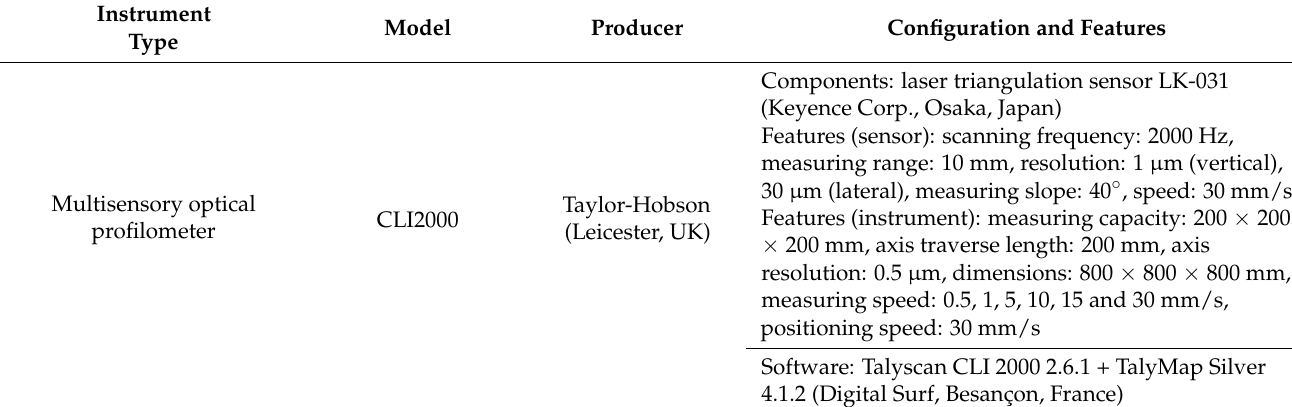
Table 8. Characteristics of measurement system used in experimental studies